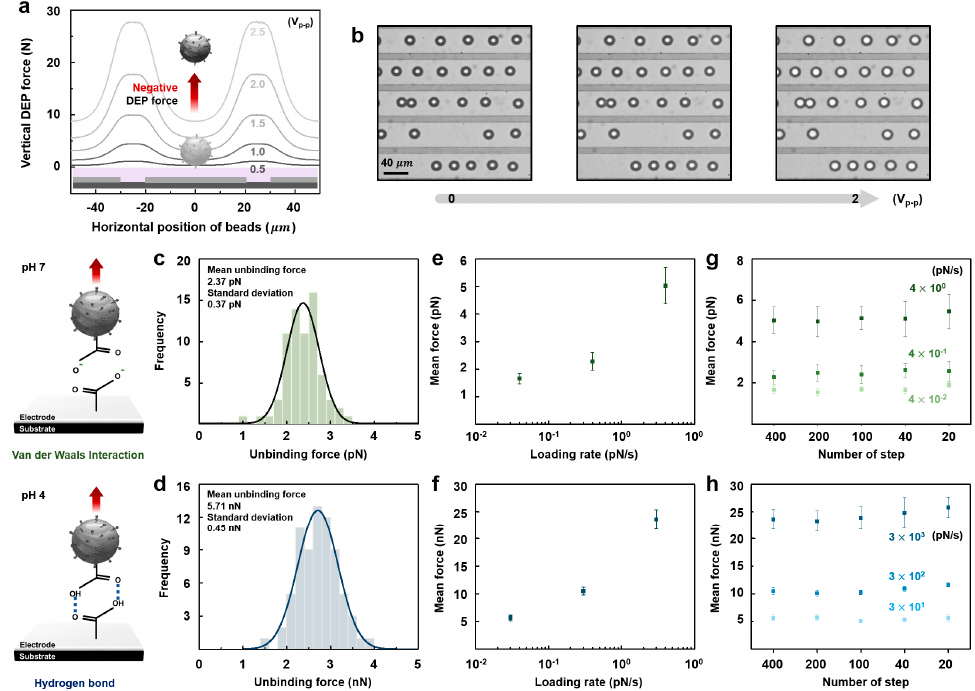
Figure 4. Numerical and experimental results: ( a ) numerical results of a DEP force and schematic illustration of the movement of the carboxyl-terminated molecule functionalized particle by a negative DEP force; ( b ) optical images of the movement of the arranged particles as the voltage increased from 0 V peak-to-peak to 2 V peak-to-peak , ( c , d ) the measured unbinding forces: van der Waals interaction ( c ) and hydrogen bond ( d ); ( e , f ) the mean forces for a varying force loading rate: van der Waals interaction ( e ) and hydrogen bond ( f ); ( g , h ) the mean force with a varying ramping rate in combination with a force loading rate: van der Waals interaction ( g ) and hydrogen bond ( h ).